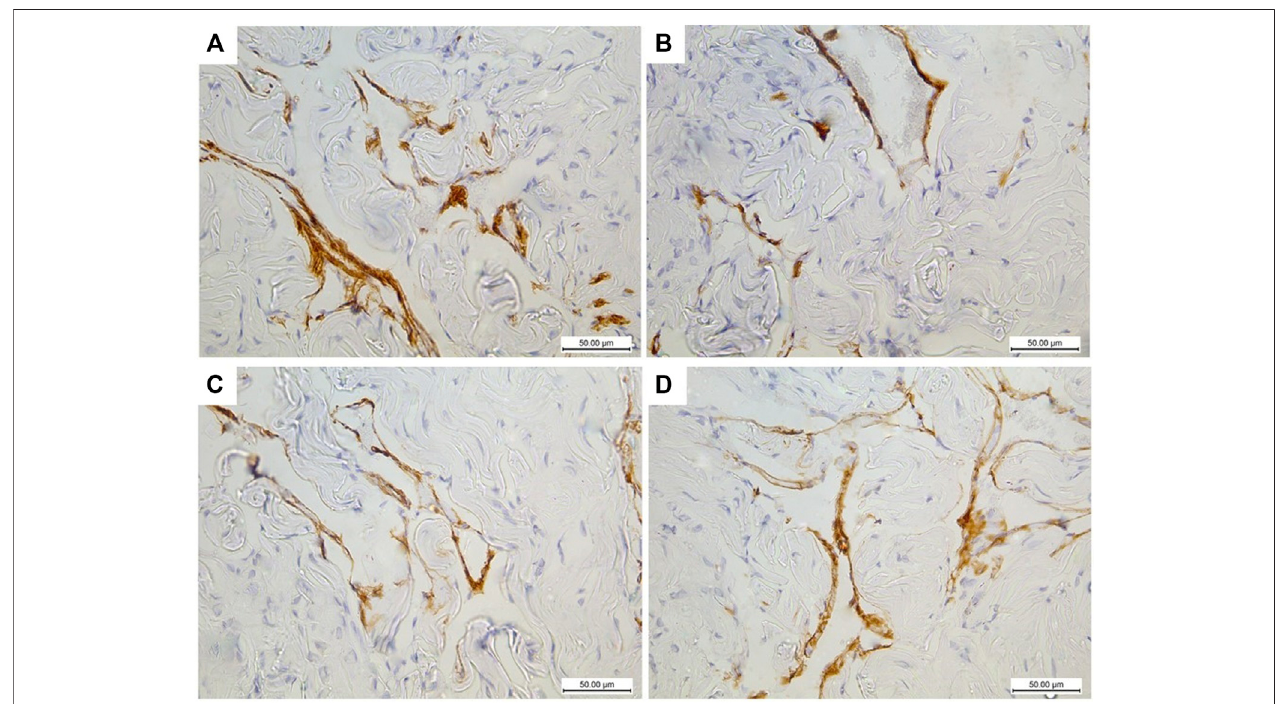
FIGURE 8 | Histological transverse sections of the penises of all rats in all groups immunohistochemically stained with anti- α -SMA antibody showing diminution of itsexpressionindiabeticgroup(groupII) (B) incomparisontothecontrolgroup(groupI) (A) andrestorationofitsexpressioningroupsIIIandIV (C) and (D) ,respectively. X400. Scale bar: 50 μ